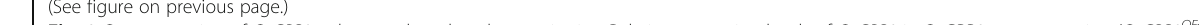
( 35S::OsGRP-GFP ) in rice protoplasts together